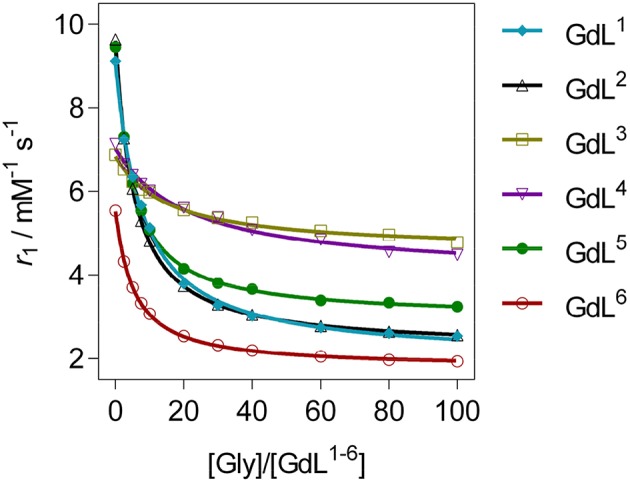
1H longitudinal relaxometric titration curves for GdL1−6 with Gly ([GdL1−5] = 3.0 mM, pH 7.4 or [GdL6] = 1.0 mM, pD 7.8, 50 mM HEPES, 298 K, B0 = 7.05 T). The lines represent the fits as explained in the text.